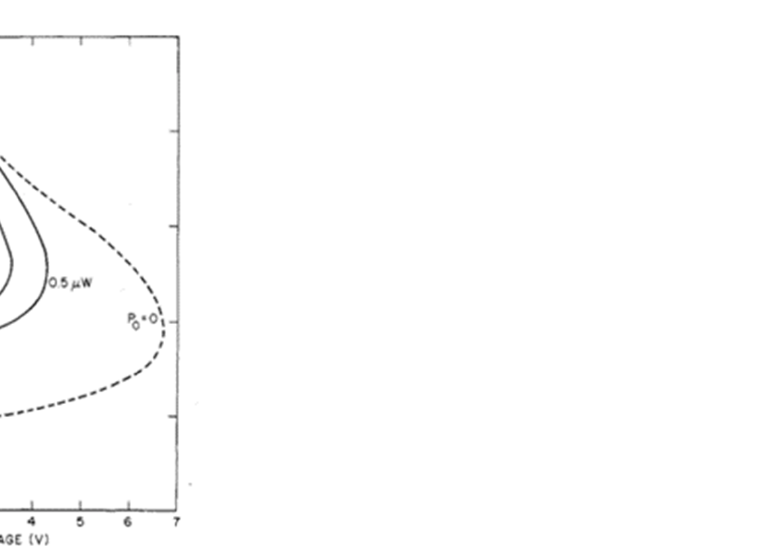
Figure 47. I–V characteristic curves of InGaAs/InP APTs under 0.5 µ W, 0.95 µ W, 2 µ W illumination. Reproduced with permission from [100], IEEE, 2014.